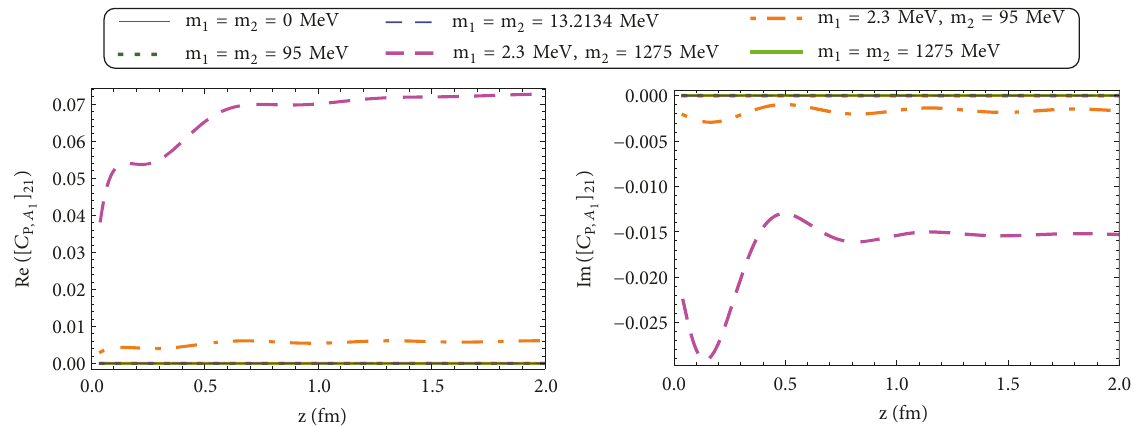
Figure 14: Real (left) and imaginary (right) parts of the conversion factor for the mixing coefficient for the operator pair ( 𝑃 , 𝐴 𝜇 ) as a function of 𝑧 , for different values of quark masses. Source: [184], reprinted with permission by the Authors (article published under the terms of the Creative Commons Attribution 4.0 International